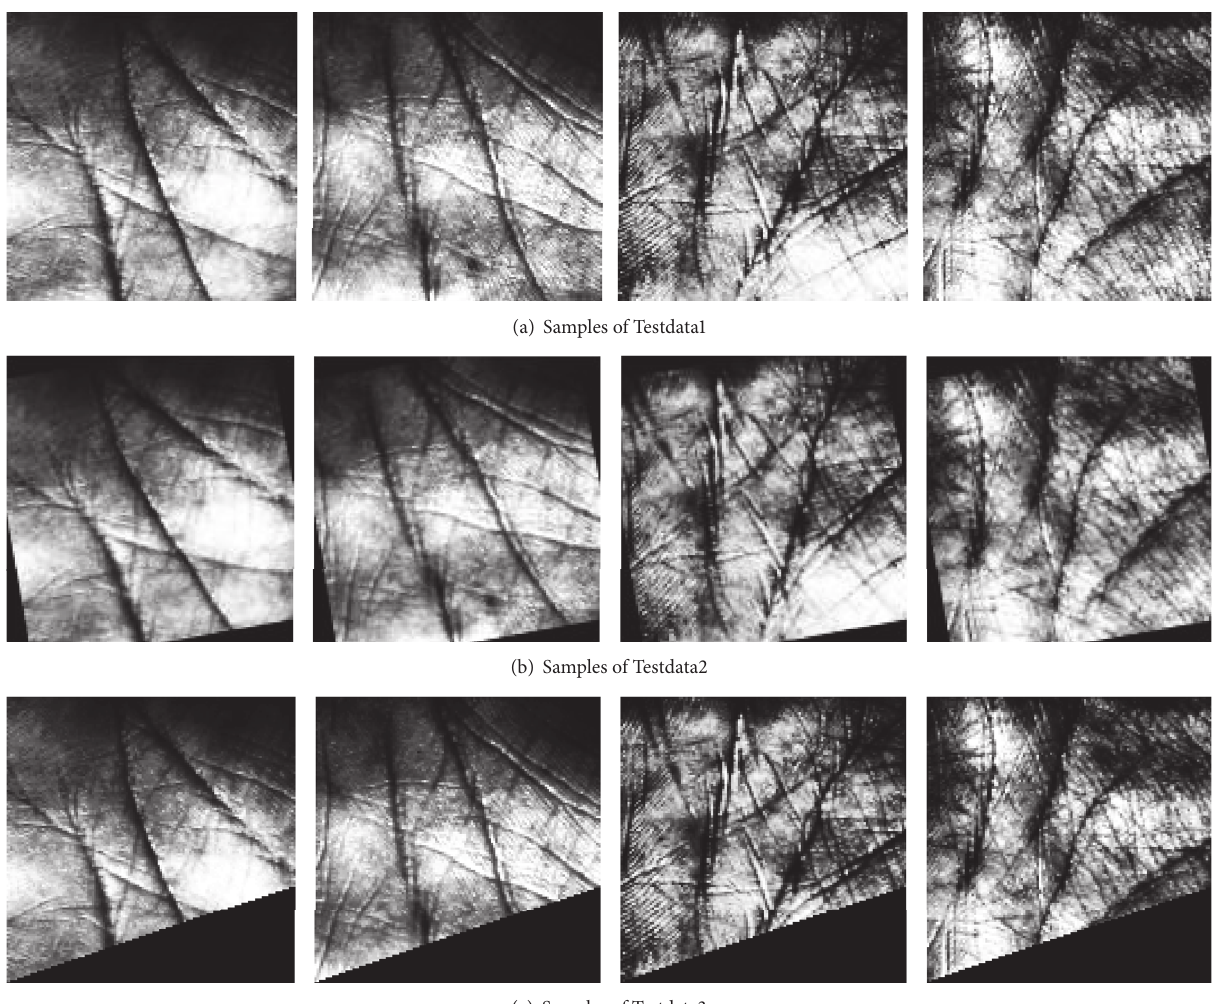
Figure 6: Some samples of Testdata1, Testdata2, and